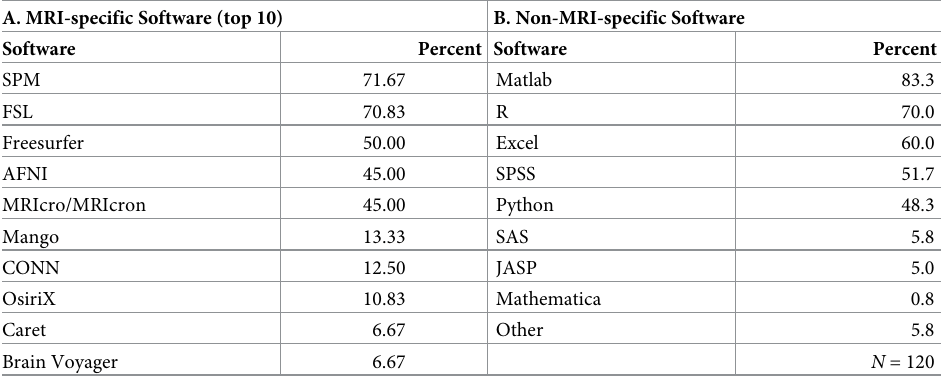
Table 4. Analysis software